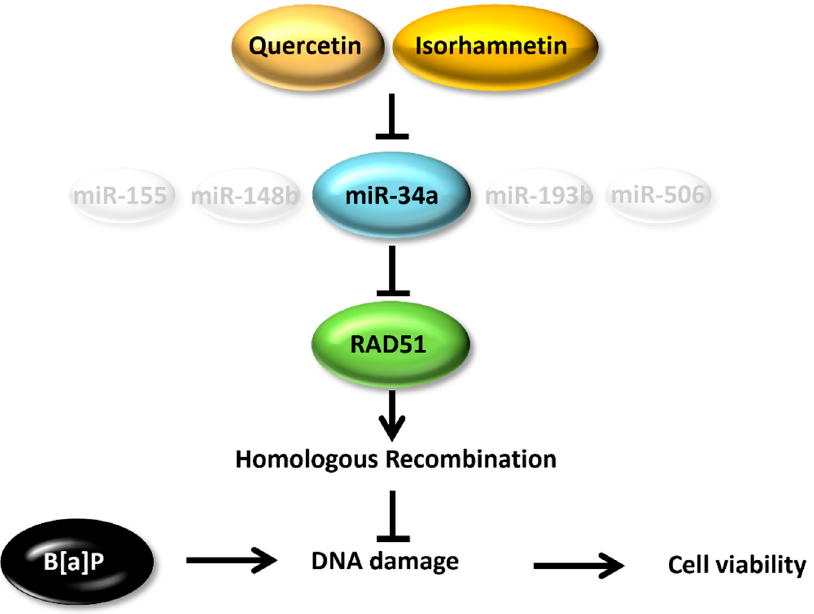
Figure 6. The mechanistic model of quercetin and isorhamnetin against B[a]P-induced genotoxicity.